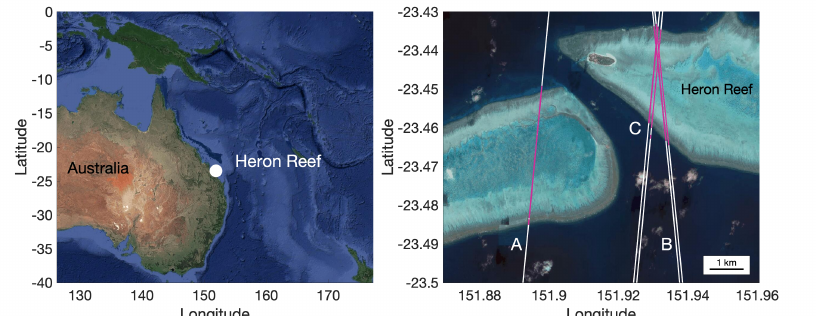
Figure 9. ( Left ) Location of Heron Reef, Australia. ( Right ) Map of ICESat-2 tracks, pink highlights areas with detected bathymetry. A: 8 April 2019, beam gt3l (strong), B: 15 September 2019, beams gt3l/gt3r(strong), C: 8 April 2019, beams